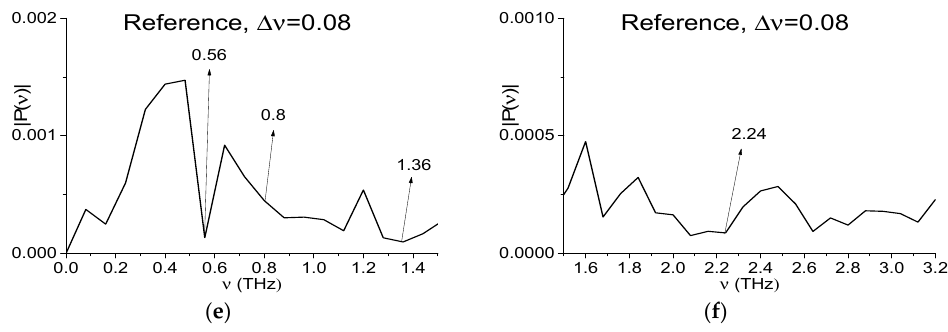
Figure 6. Fourier spectrum of the signal Chocolate ( a , b ), absorbance ( c , d ) and Reference spectrum ( e , f ) in the frequency ranges ν = [0, 1.5] THz ( a , c , e ) and [1.5, 3.2] THz ( b , d , f ), the corresponding spectral resolution is equal to Δ ν = 0.08 THz.